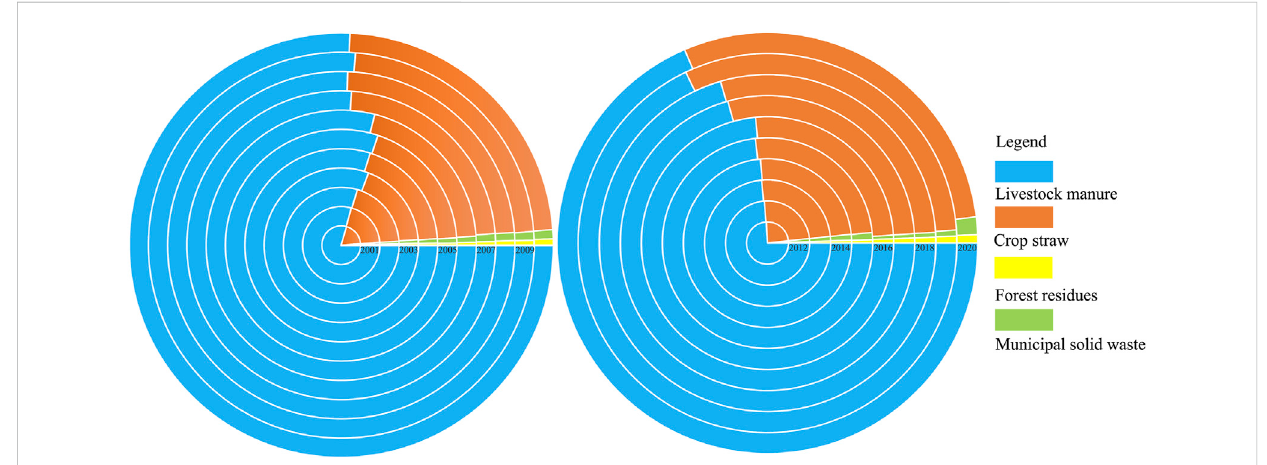
FIGURE 1 Proportion of various types of biomass energy potential converted to coal equivalent in China from 2000 to 2020.